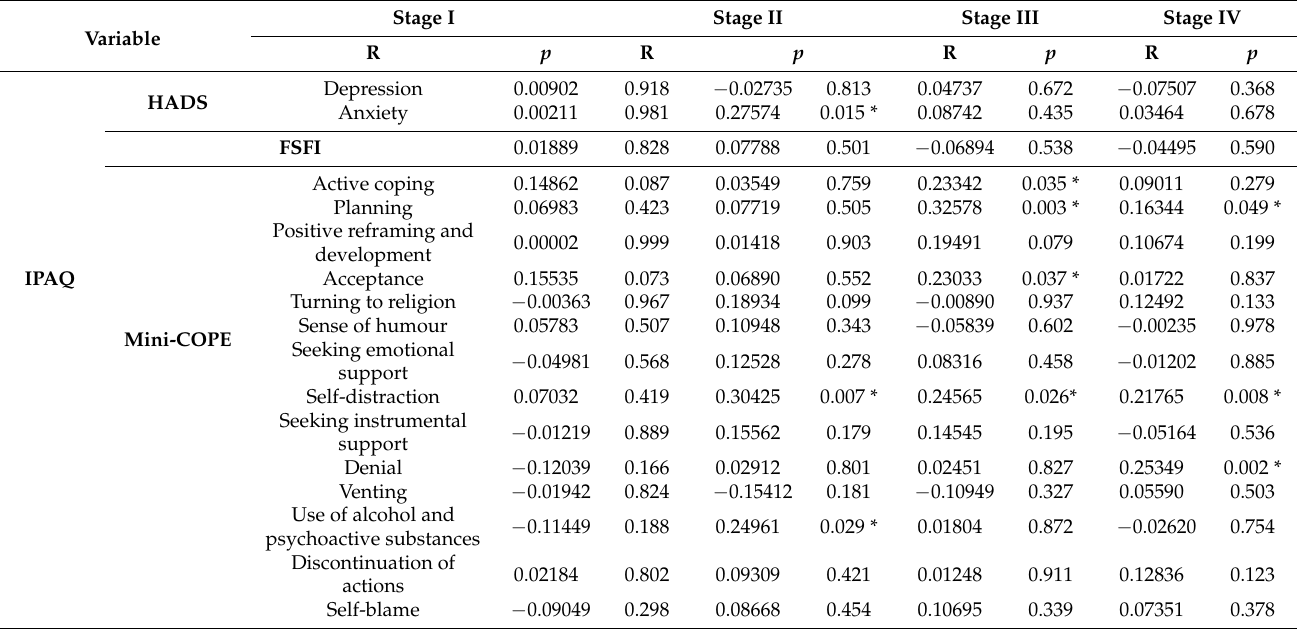
Table 5. Relationship between the level of physical activity and sexual functioning, ability to cope with stress, and the degree of anxiety and mood disorders, taking into account the clinical stage.